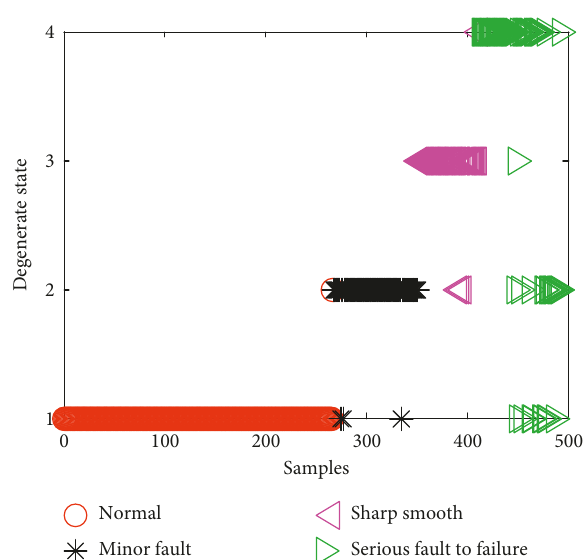
Figure 17: The recognition result of bearing degenerative state.